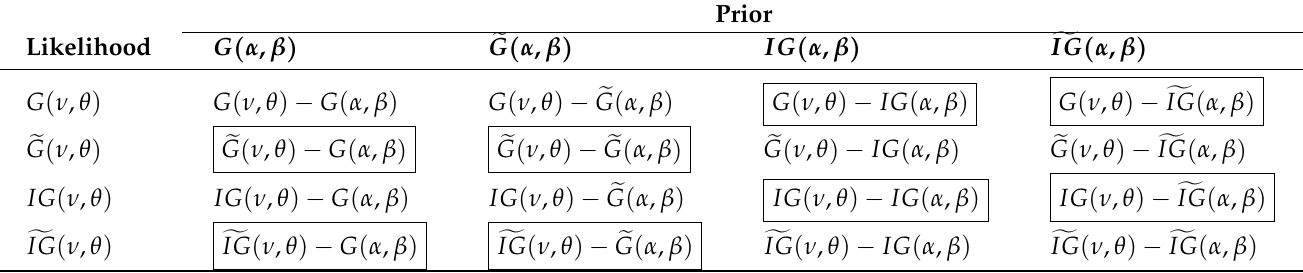
Table 1. The 16 hierarchical models of the gamma and inverse gamma distributions. The 8 hierarchical models that have conjugate priors are highlighted in boxes.